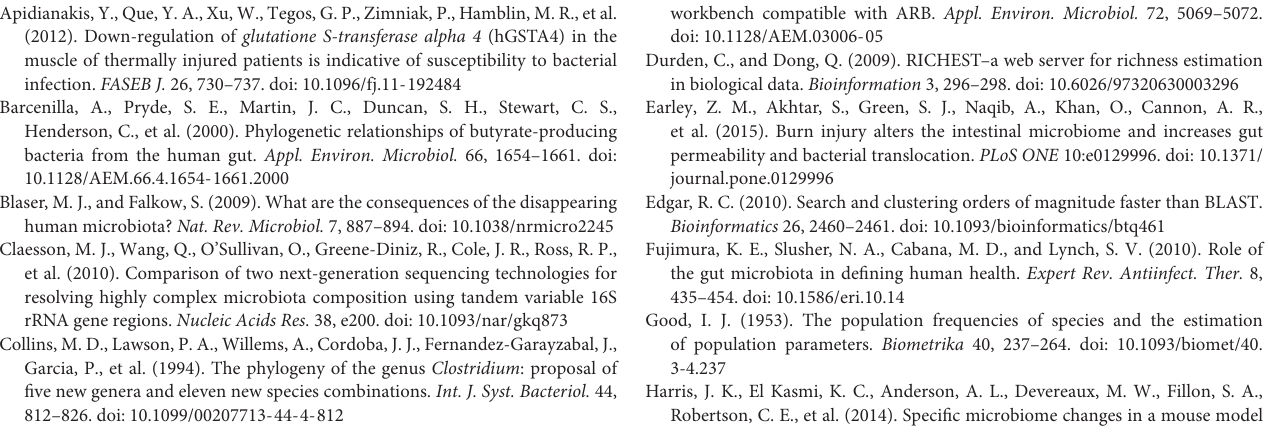
FIGURE S1 | 16S rRNA PCR results for the 20 samples. FIGURE S2 | Rarefaction analysis of each sample from the two groups. The X -axis represents the number of sequences and the Y -axis represents the